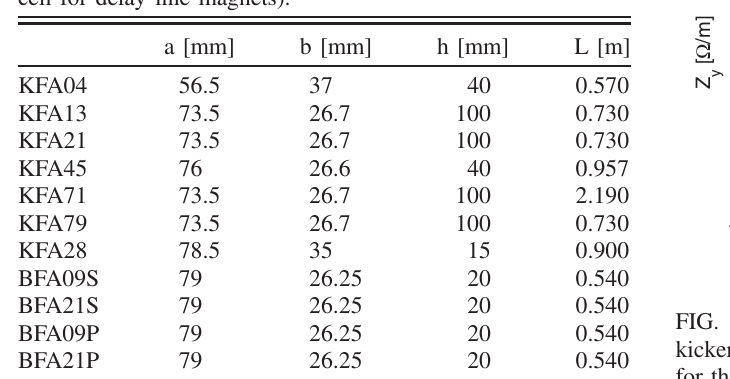
TABLE IV. PS kickers geometrical parameters: according with Tsutsui ’ s nomenclature, a is the horizontal semiaperture of the magnet (between the two conductors), b is the vertical semi- aperture of the magnet, h is the width of the ferrite and L is the total length of the ferrite (consider from the first cell to the last cell for delay line magnets).